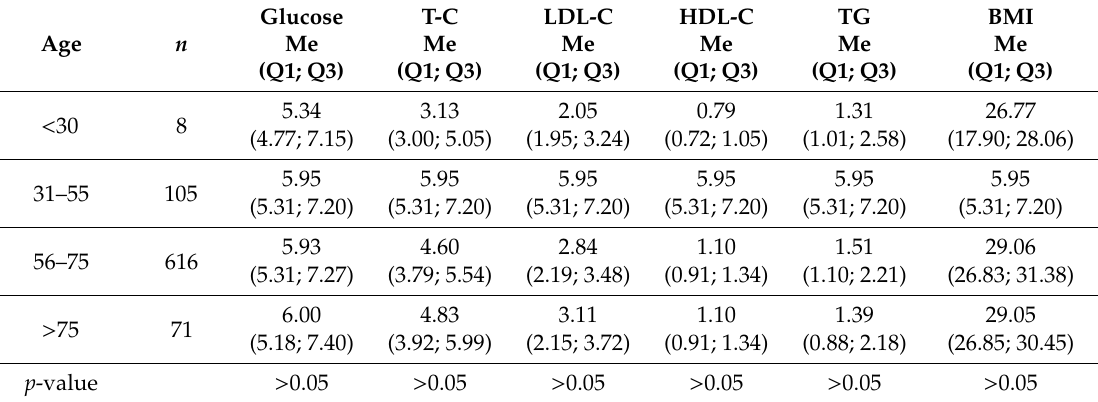
Table 9. Kruskal–Wallis rank analysis of variance (ANOVA) by age group.